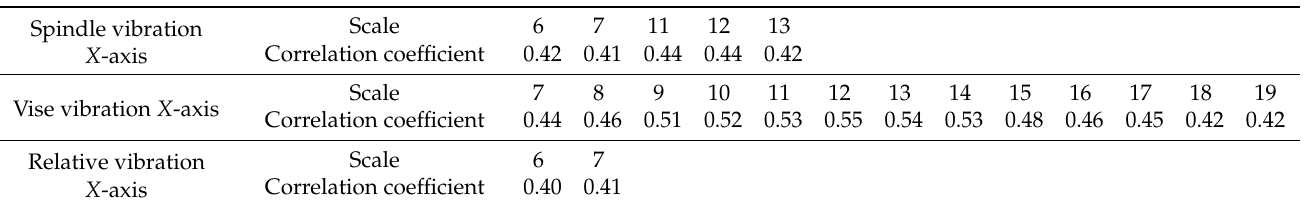
Table 3. Pearson correlation coefficients (absolute value ≥ 0.4) between multiscale entropy and the Ra values. Spindle vibration X